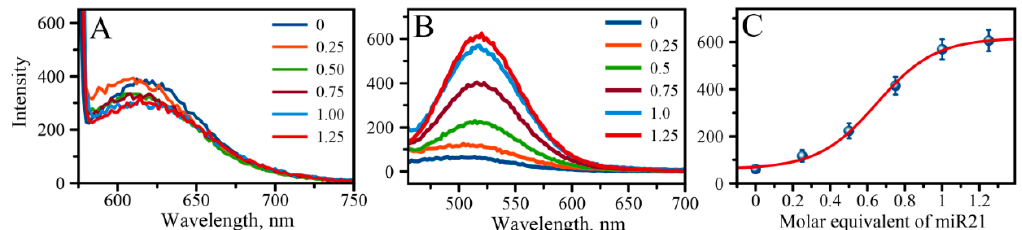
Figure 4. ( A ) Comparative graph of emission spectra for the “red” AgNCs excited at λ = 560 nm showing spectral changes upon incremental addition of molar equivalent of miR-21 to AgNC/C 12 -loop-miR21-probe; ( B ) Comparative graph of emission spectra for the “green” AgNCs excited at λ = 480 nm showing spectral changes upon incremental addition of molar equivalent of miR-21 to AgNC / C 12 -loop-miR21-probe; ( C ) Fluorescence intensity plot, λ EXC / λ EM = 480 / 565 nm, as a function of miR21 molar equivalent concentration showing the fit (red solid line) using Equation (1), error bar represents variations based on three independent measurements.